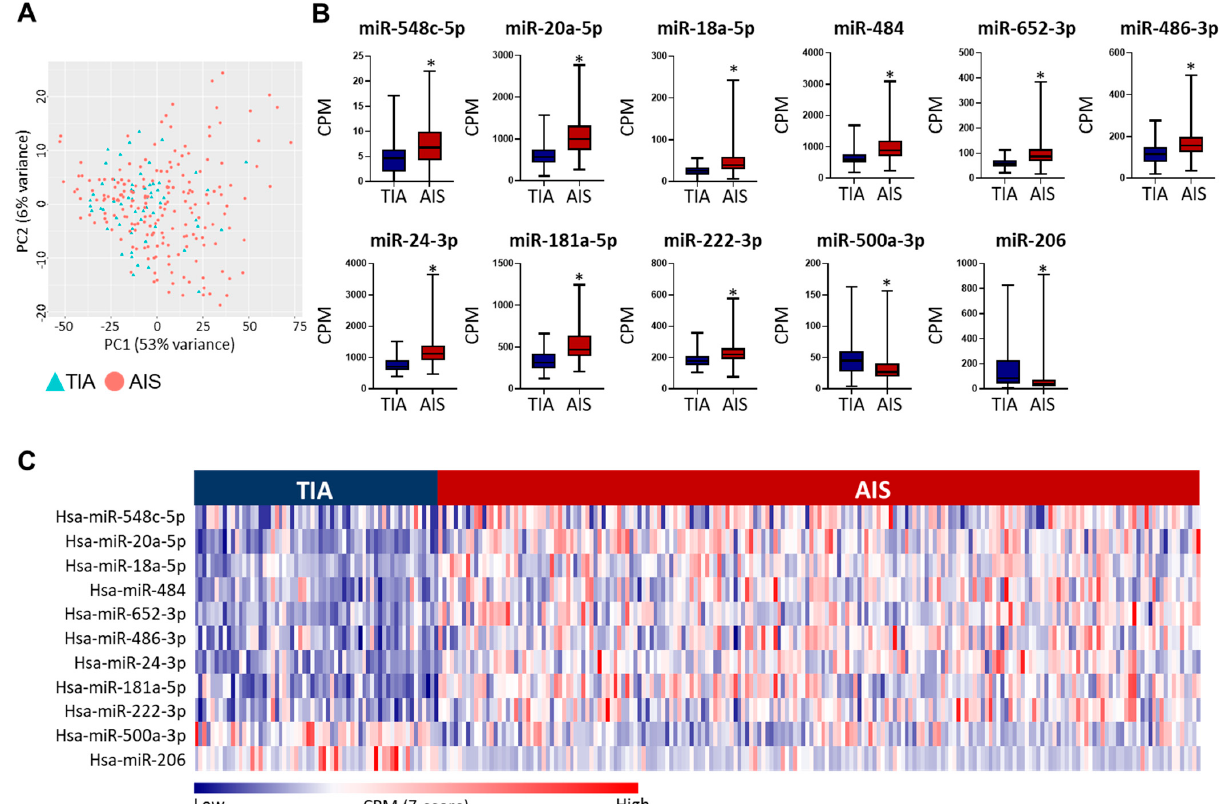
Figure 2. Circulating miRNA profiles of acute ischemic stroke (AIS) and transient ischemic attack (TIA) patients. ( A ). PCA plot depicts the variability in miRNA expression between TIA and AIS patients. ( B). Box and whiskers plots show the differences in counts per million (CPM) in AIS and TIA patients of the 11 differentially regulated, validated miRNAs. Mean with minimum and maximum values, and upper and lower quartiles are depicted for each data set with significant comparisons annotated by an asterisk (*) on top ( p < 0.0001). ( C ). Heatmap shows the dysregulation in identified miRNA panel (Z-scores calculated CPM) between AIS and TIA patients in the overall study population.